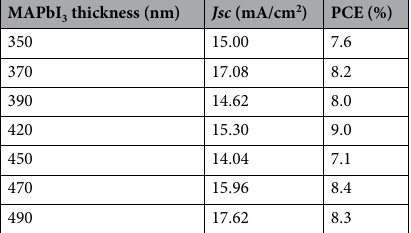
Table 2. Dependence of the short-circuit current density ( Jsc ) and power conversion efficiency ( PCE ) on the MAPbI 3 thickness.